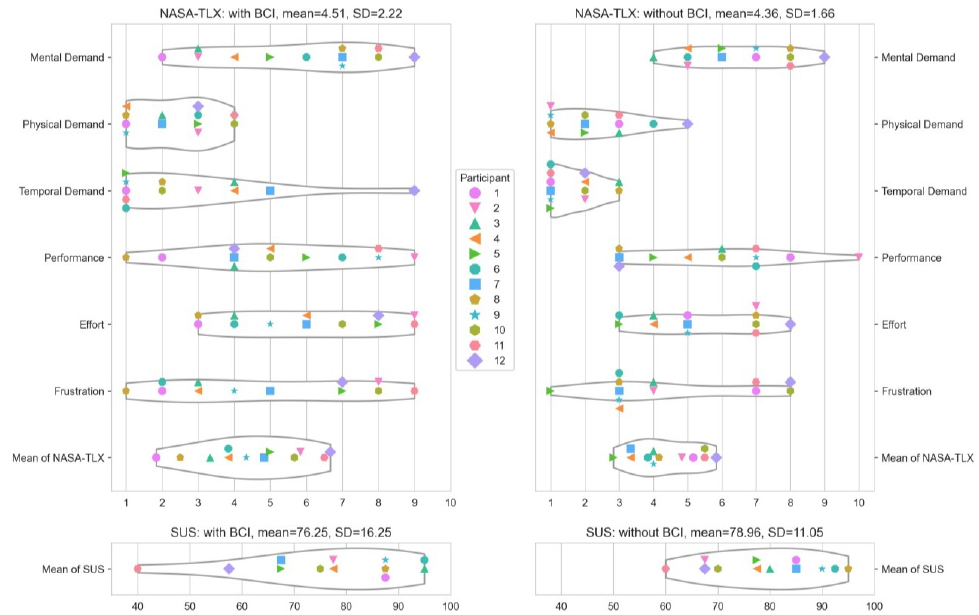
Figure 11. NASA-TLX and SUS ratings per participant for BCI and BCI-less versions of the AR translator app.